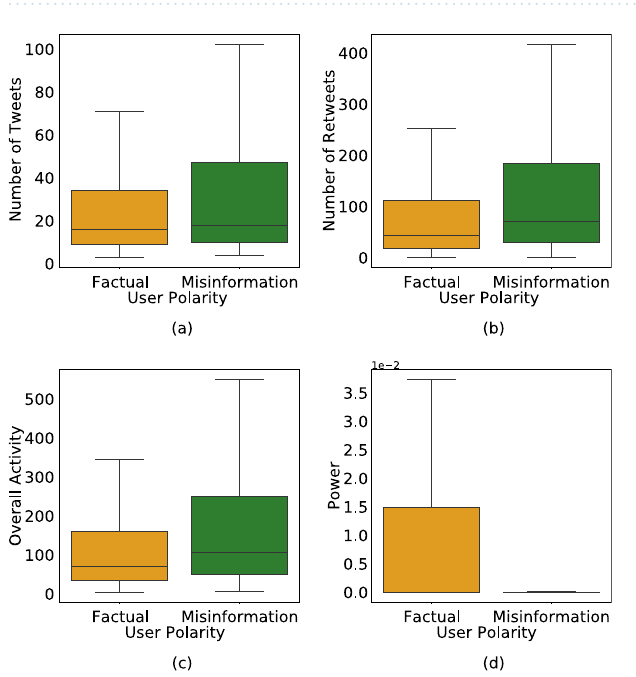
Figure 5. Boxplots comparing activity and power of factual ( f l ≥ 0.6 ) and misinformative users ( f l ≤ 0.4 ). While we notice that misinformative users are more active both in terms of number of tweets and retweets generated, they are retweeted less com- pared to factual users. Subsequently, the ratio of retweets received to overall activity is significantly lower for misinformative users than factual